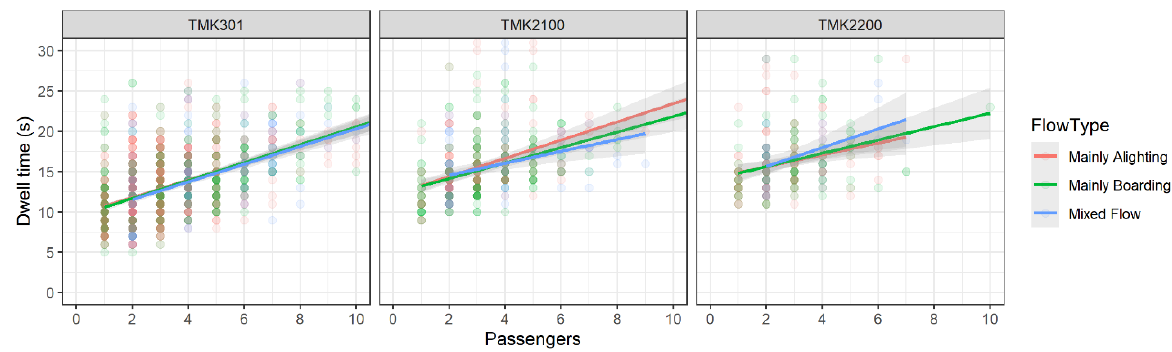
Figure 13. Distribution of passengers alighting and boarding tram vehicles.